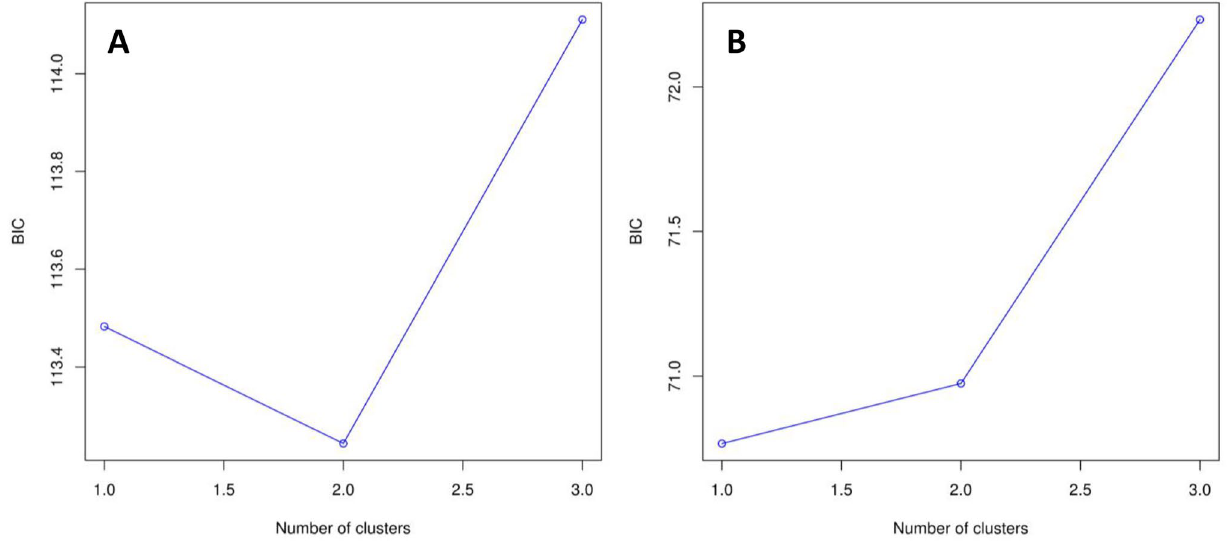
Figure 1. The number of genetic clusters in the great tit ( A ) and blue tit ( B ), as inferred with the lowest BIC criterion in the Discriminant Analysis of Principal Components (DAPC). Figures were created in R v.3.6.3 statistical environment (https:// www.R- proje ct.